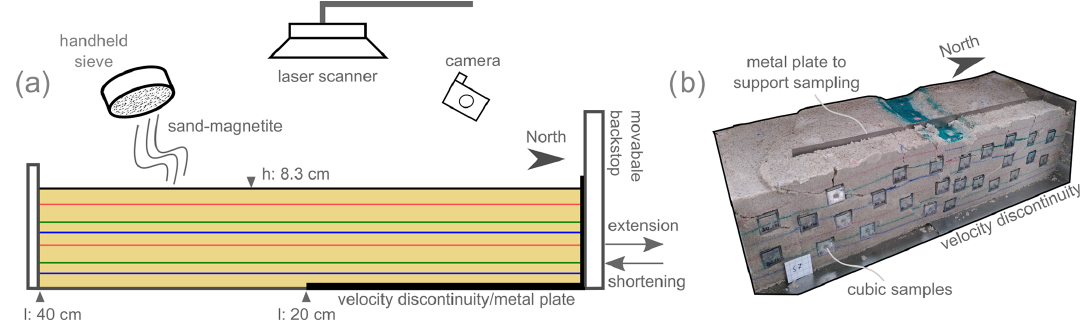
Figure 1. (a) Sketch of model setup. Sieved layers of the sand–magnetite mixture are separated by coloured sand layers. A basal metal plate was used as velocity discontinuity and attached to the backstop that moved backwards for extension and forwards for shortening the model. The models were monitored by taking pictures from different angles with a camera, and model surfaces were monitored by laser scanning during deformation. (b) Photo of section number 7, which is an oblique view of Model III with inserted sample cubes, showing the procedure of sampling of the